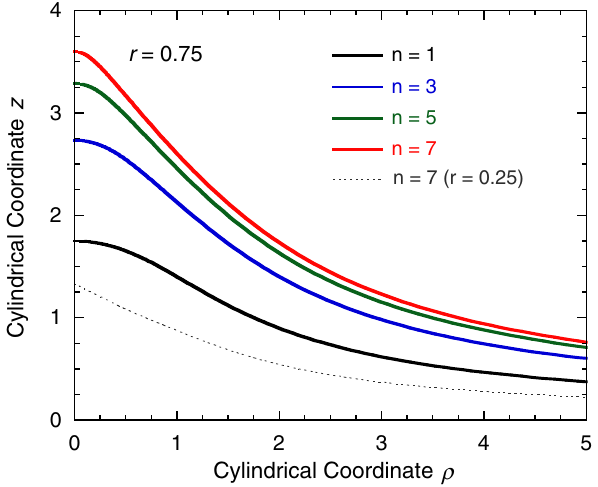
FIG. 2. (Color) The shape of the emitter in the point-charge model for different values of n for r (cid:2) 0 : 75 . Also shown is the n (cid:2) 7 , r (cid:2) 0 : 25 surface.